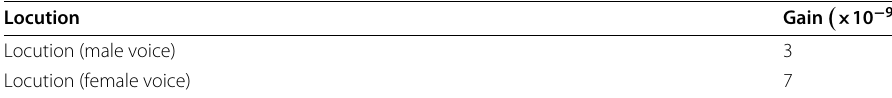
(cid:2) (cid:3) × 10 − 9